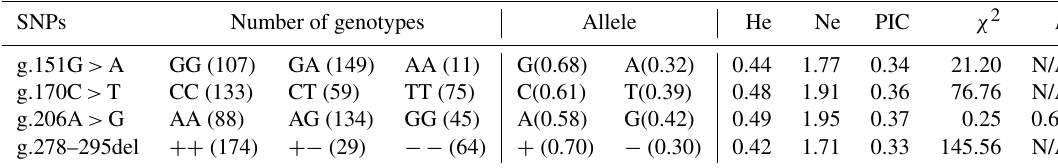
Table 1. Population genetic indexes of four polymorphisms in signal peptide coding of VLDLR. SNPs